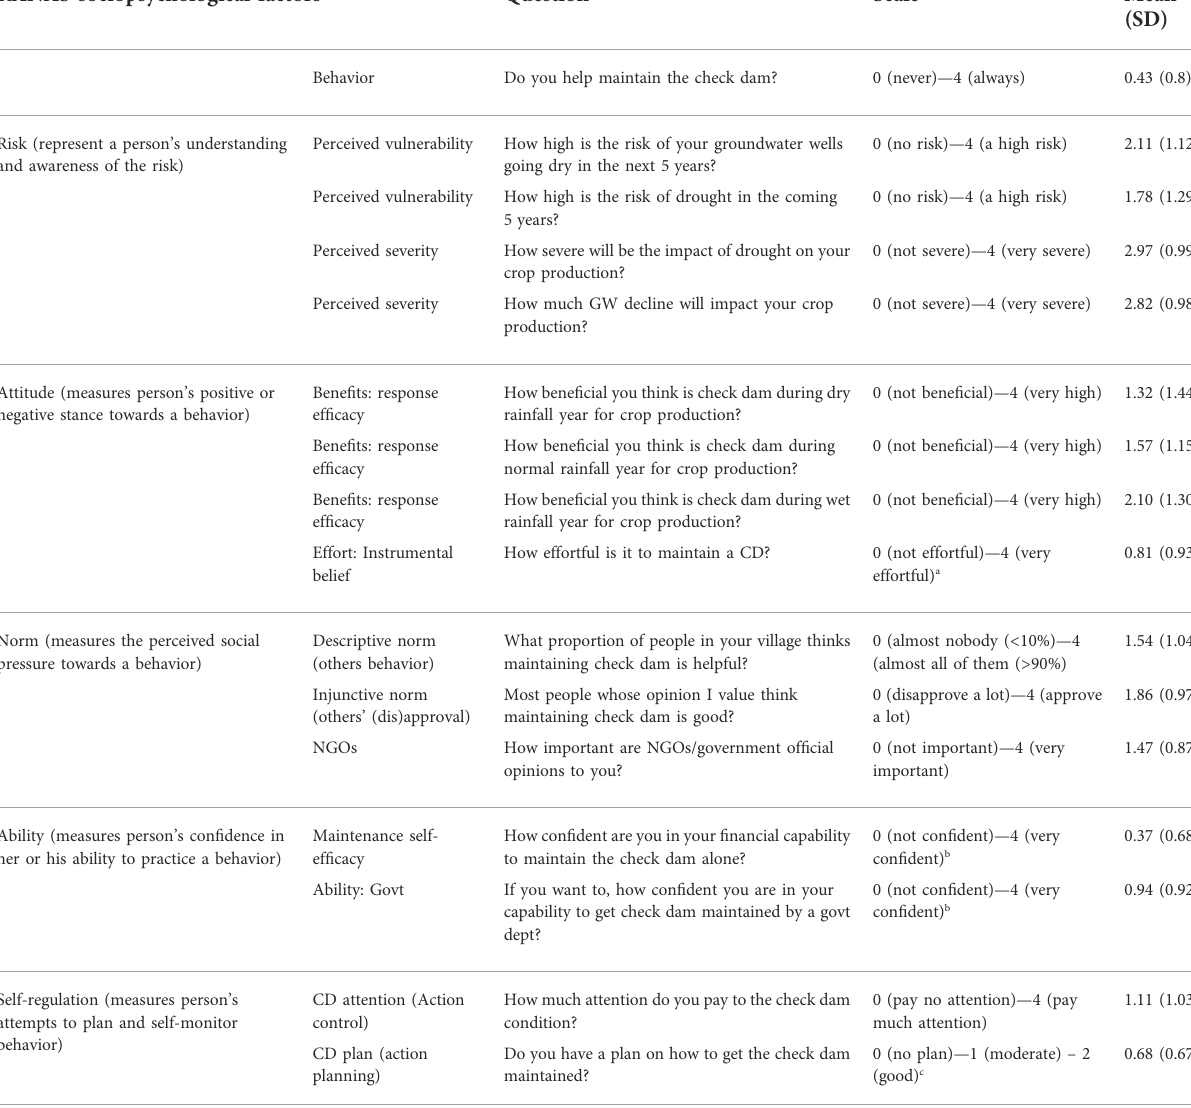
TABLE 1 RANAS sociopsychological factors and questionnaire with descriptive statistics. RANAS sociopsychological